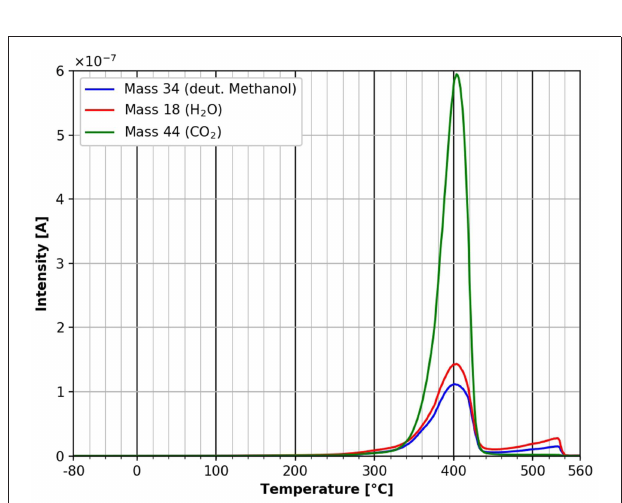
FIGURE 10 | Desorption of deuterated methanol (mass 34, blue), carbon dioxide (mass 44, green) and water (mass 18, red) in the temperature range between − 80 and 560 ◦ C.